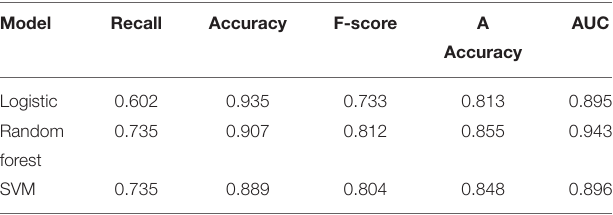
TABLE 1 | The comparison of the performance of data after three classification models applied to health information statistics for children’s health diagnosis and intelligence development.